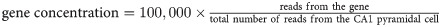
Exon-inclusion level estimation, false positive rate comparison and power comparison of simulation study.Informative read counts of 1,000 exon groups for 600 cells (300 vs 300) were simulated using a generative model shown in S1 Fig with cell-specific technical parameters estimated from CA1 pyramidal cells in the scRNA-seq data generated by Zeisel et al. [16]. To simulate data that resemble real scRNA-seq data, one CA1 pyramidal cell was randomly selected and read coverage for each gene in that cell was used to obtain true gene concentration at the population level (geneconcentration=100,000×#readsfromthegene#totalnumberofreadsfromtheCA1pyramidalcell). Based on the generative model accounting for technical noise, we generated 6,000 reads on average for each cell. (A) Scatter plots of 1,842 true exon-inclusion levels, estimated by percent spliced in (PSI) for a given exon, against estimates from SCATS and a naïve method that ignores technical noise. SCATS models technical noise to quantify usage of an alternatively spliced exon while the naïve method simply estimates the inclusion level by ψ=Y+Y++Y−, where Y+ and Y− are the informative read counts of the “+” and “-” exon groups across cells. SCATS estimates are closer to the ground truth. (B) Quantile-quantile plots of the p-values from SCATS, Census and DEXSeq under the null hypothesis (Δ = 0). X-axis represents uniform theoretical quantiles between 0 and 1 in –log10 scale. Y-axis represents observed p-value quantile in –log10 scale. Uniformly distributed data should follow the red dashed line. P-values of SCATS are more uniformly distributed while those from Census are right-skewed and those from DEXSeq are left-skewed. (C) Type I error comparison of SCATS, Census and DEXSeq with different significance levels (α = 0.05, 0.01, 0.005). Similar to (B), SCATS has better type I error control than Census and DEXSeq. (D) Power comparison of SCATS, Census and DEXSeq. Barplots show the estimated power under different effect sizes (Δ = 0.1,0.2,0.3,0.4), where significance was evaluated at 0.05, 0.01, and 0.005 levels, respectively. Colors indicate different methods. SCATS outperformed Census and DEXSeq across all effect sizes, especially when Δ = 0.1. DEXSeq is conservative in detecting DAS events.